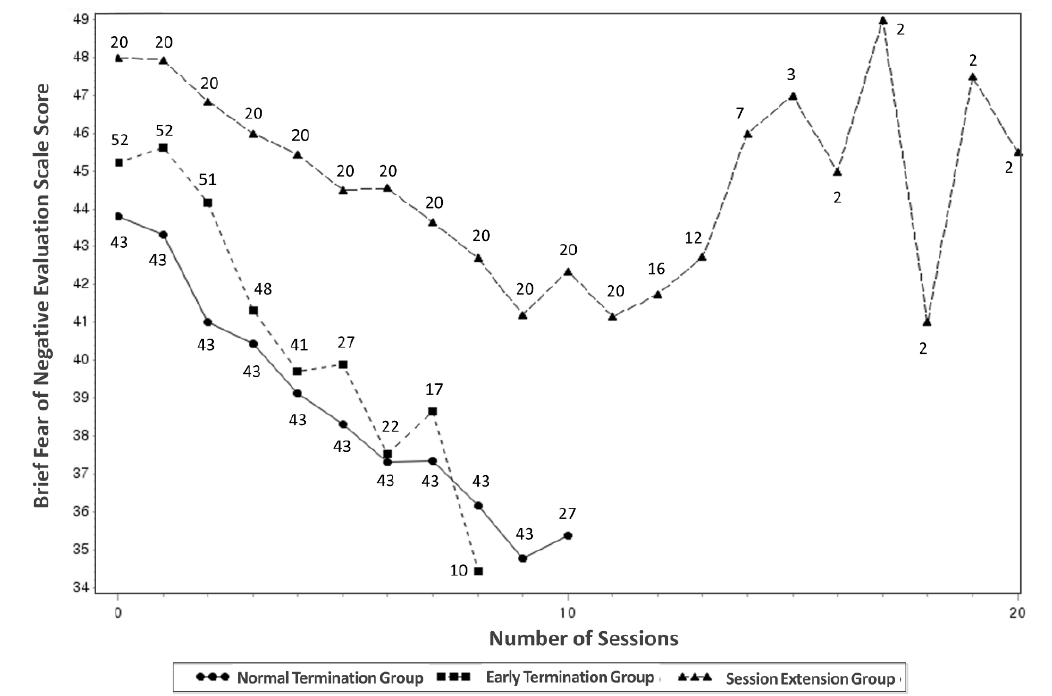
Figure 1. Plots of the mean scores of Brief Fear of Negative Evaluation Scale and the number of participants in each session among the early termination, normal termination, and session extension groups.